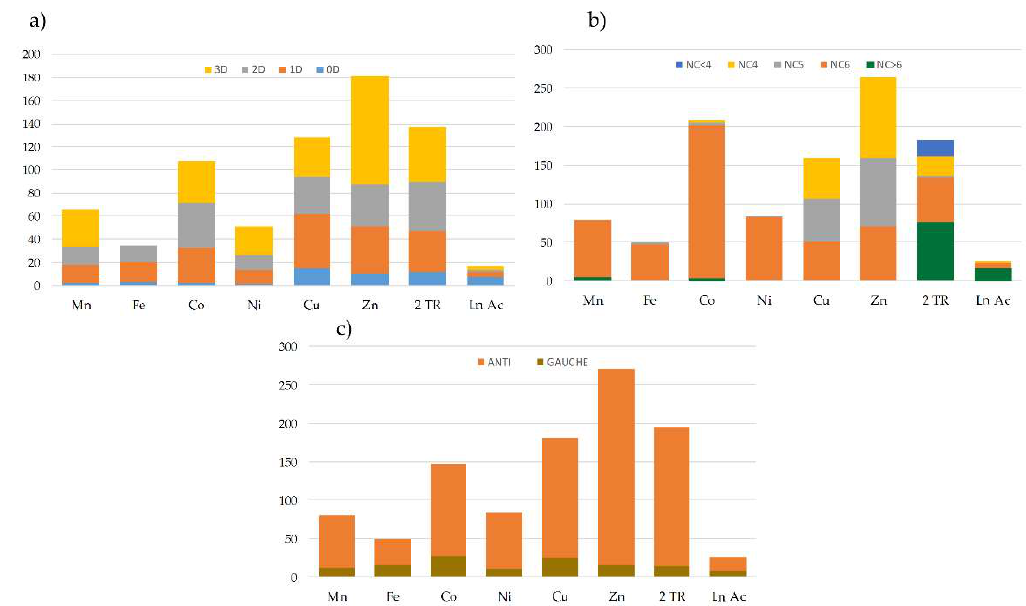
Figure 7. ( a ) Graphical representation of the number of structures with different dimensionalities (0D, 1D, 2D and 3D) containing bpa as a bridge between the different metal centers; ( b ) Graphical representation of the number of structures with different coordination environments (NC < 4, NC4, NC5, NC6, NC > 6) containing bpa as a bridge between the different metal centers; ( c ) Graphical representation of the number of structures with different conformational states ( anti and gauche ) containing bpa as a bridge between the different metal centers.